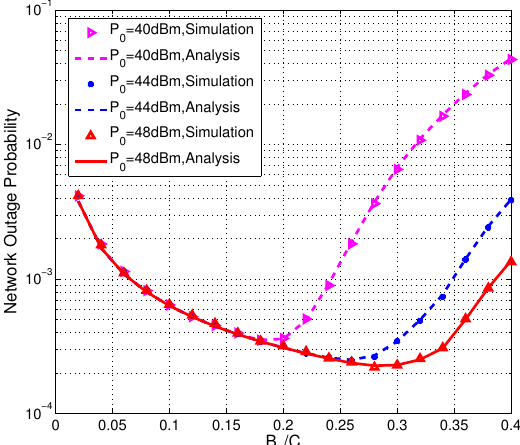
Figure 5. Network outage probability versus the normalized activation energy threshold B a / C